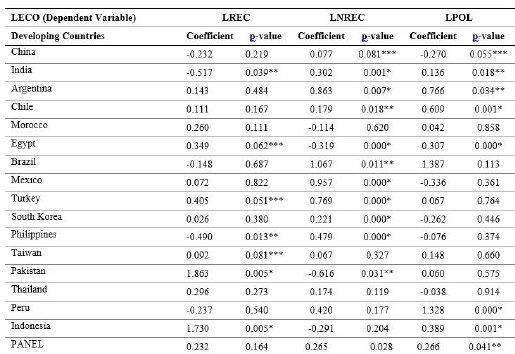
Notes: *, ** and *** represent 1%, 5% and 10% significance levels, respectively. The t statistics